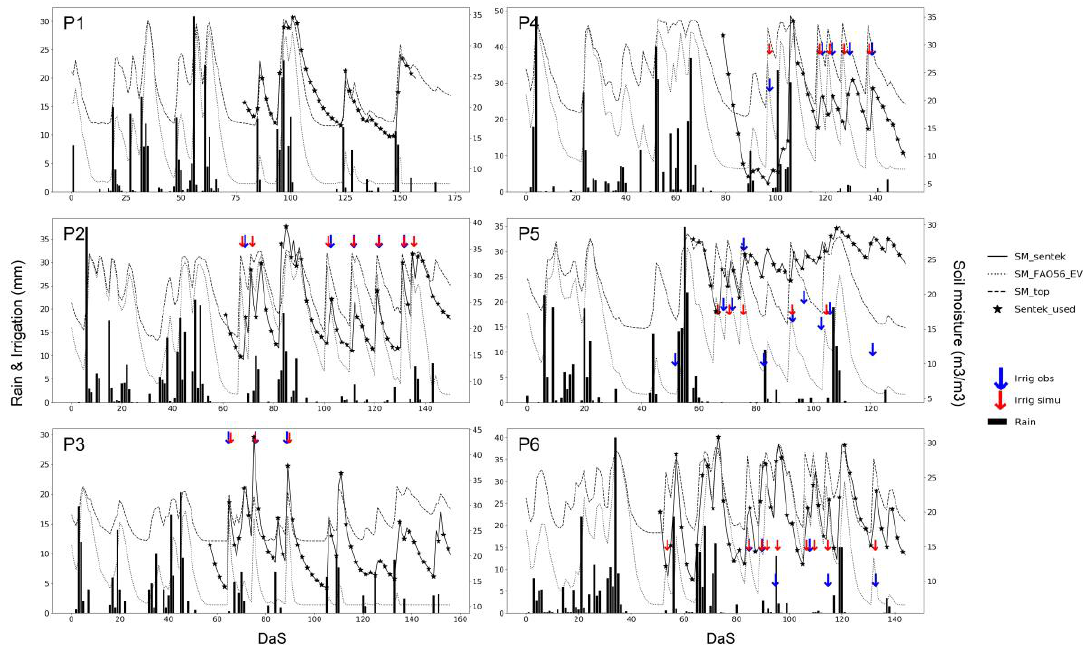
Figure 5. Irrigation detection for six plots using SSM Sentek with a time step of two days and k equal to 2. The soil moisture variables are shown as volumetric percentages (right axis). Rainfall and irrigation events are given in millimeters (left axis). The scale on the horizontal axis corresponds to the number of days since sowing. Table 3. Irrigation detection scores using SSM Sentek with 1 – 6 day intervals (rows), with k ranging from 1 to 4 (columns). The last six rows are the scores for the total number (29) of observed irrigation events.